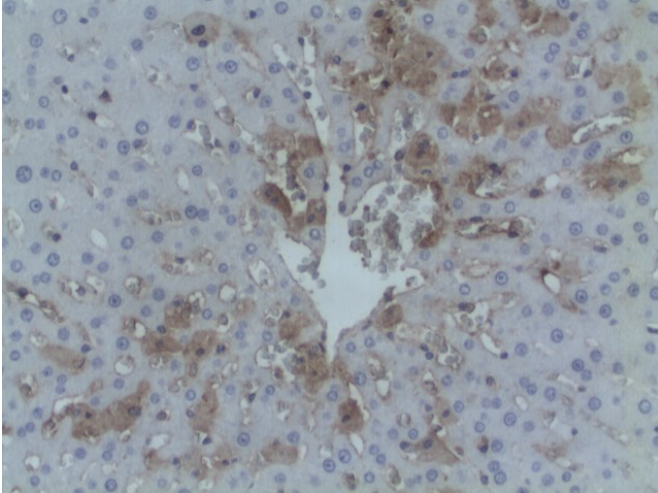
FIGURE 6 - Liver. Photomicrograph displaying moderate number of apoptotic cells identified by brown staining in a rat of the L-Ala-Gln (G-3) group. Immunohistochemistry.